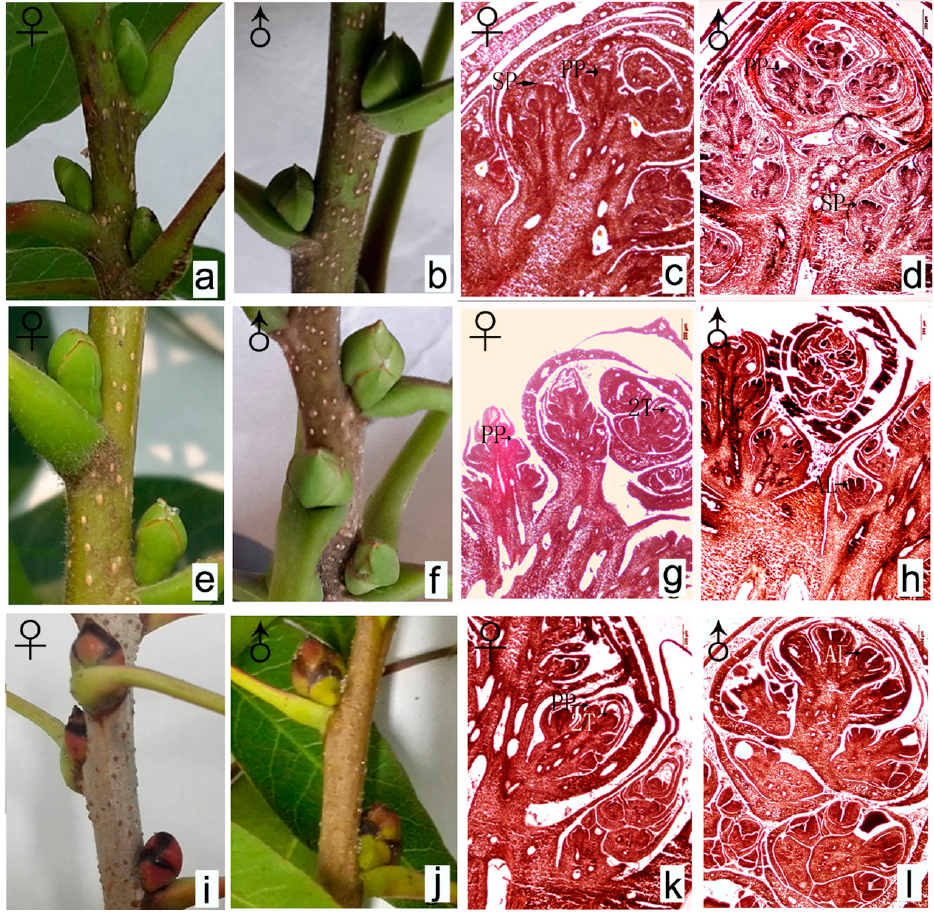
Figure 5. The external and internal morphological changes of female and male flower buds during sex differentiation phases in monoecious Pistacia chinensis . Bisexual stage of sex differentiation (